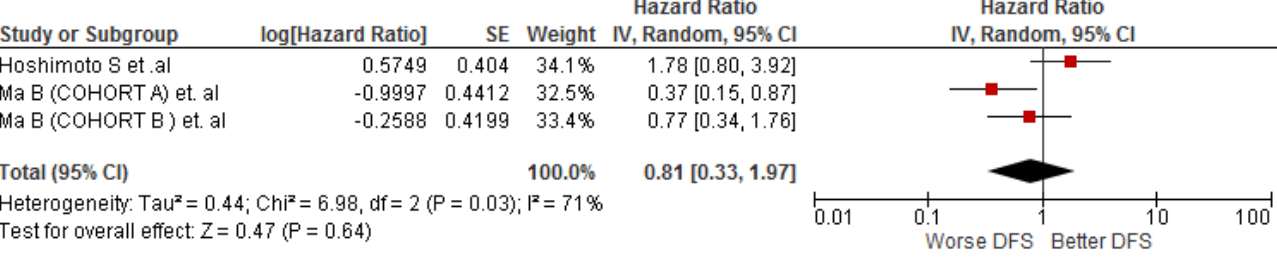
Figure 4. Association of LMR and RFS in patients with cholangiocarcinoma.